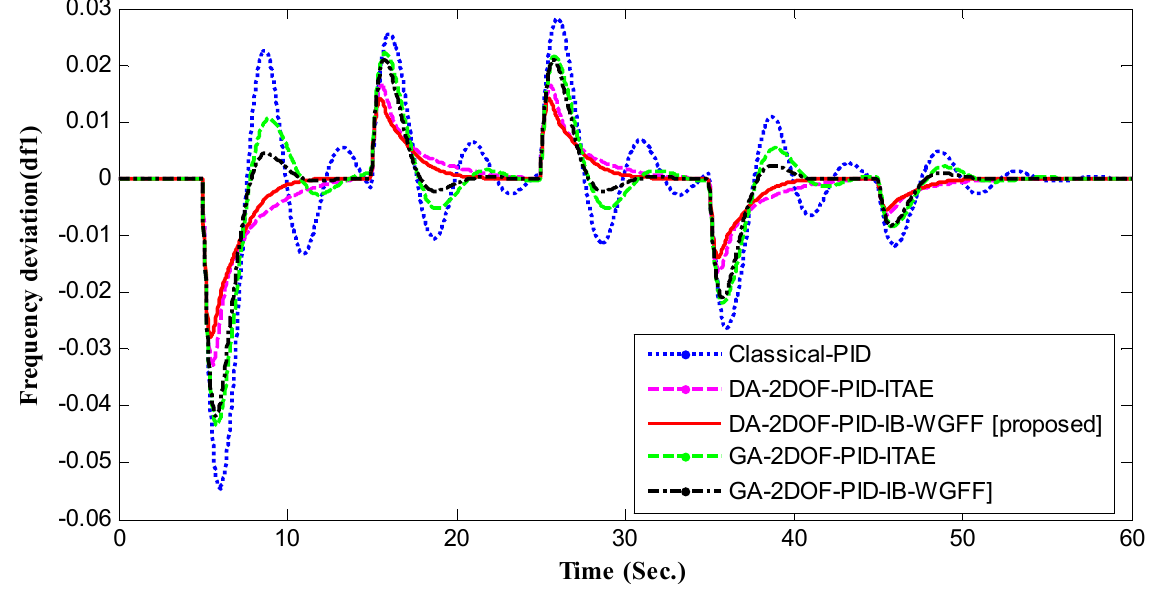
Figure 35. Δf (cid:2869) for area 1 under load disturbances.